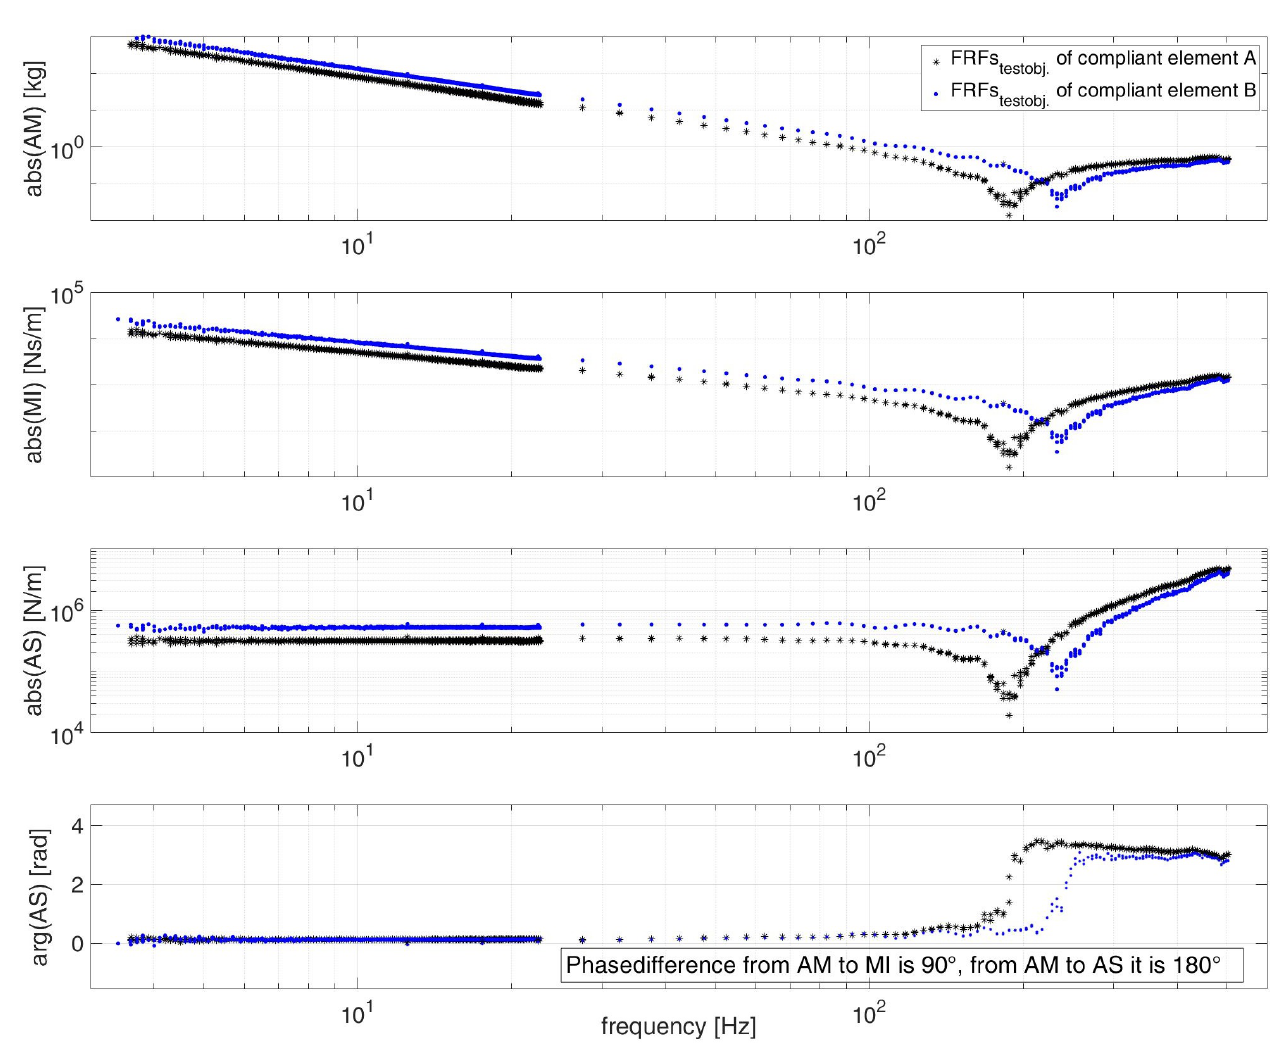
Figure 11. Calibrated FRFs AM, MI, AS and its phase of the compliant elements A and B with double and single rubber buffer in each stack over